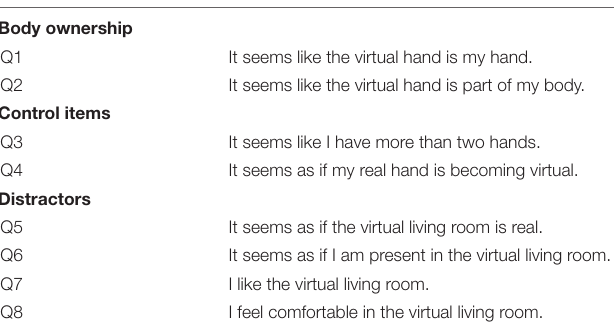
TABLE 1 | Baseline Questionnaire (BA-Q).